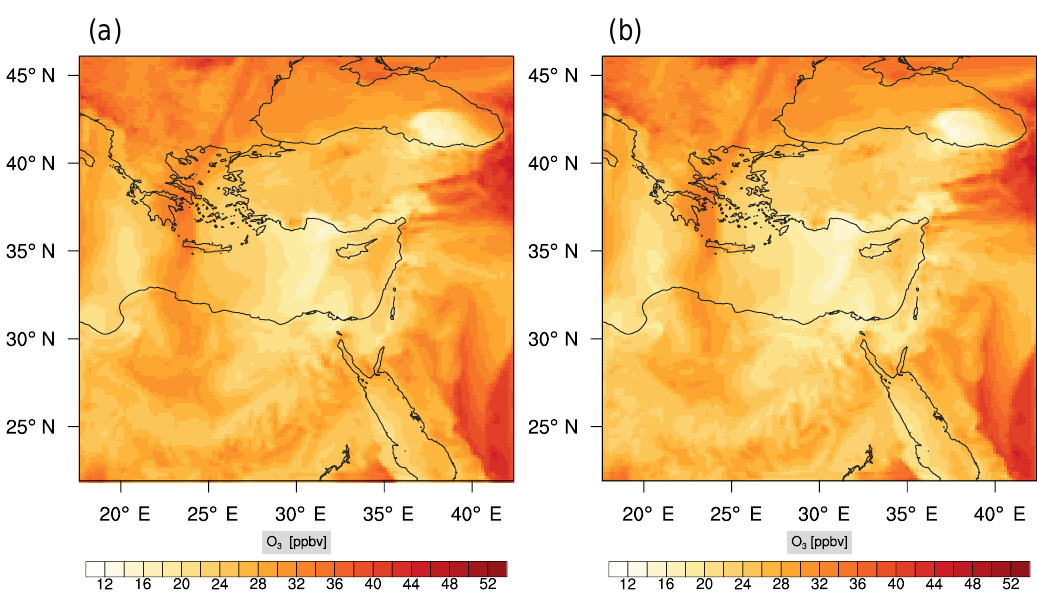
Figure 7. Instantaneous comparison of the ozone spatial mixing ratio, averaged over the first nine vertical layers, using the full mechanism (a) and the skeletal mechanism (b) .